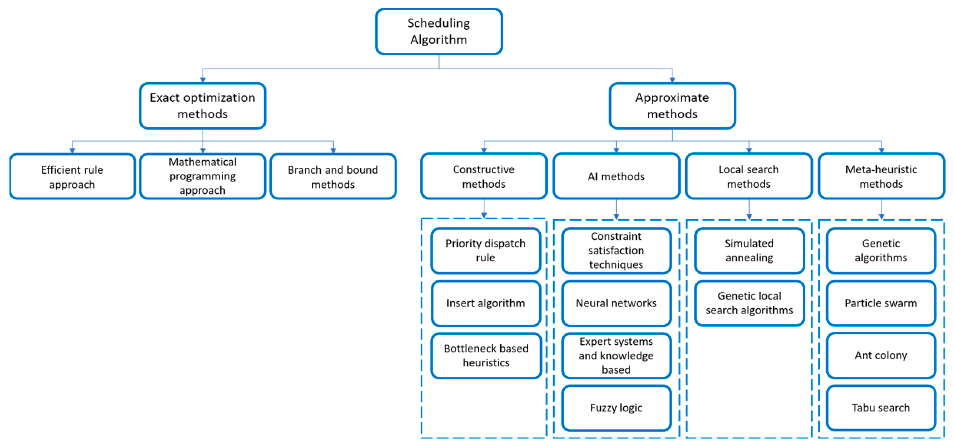
Figure 5. Scheduling algorithms